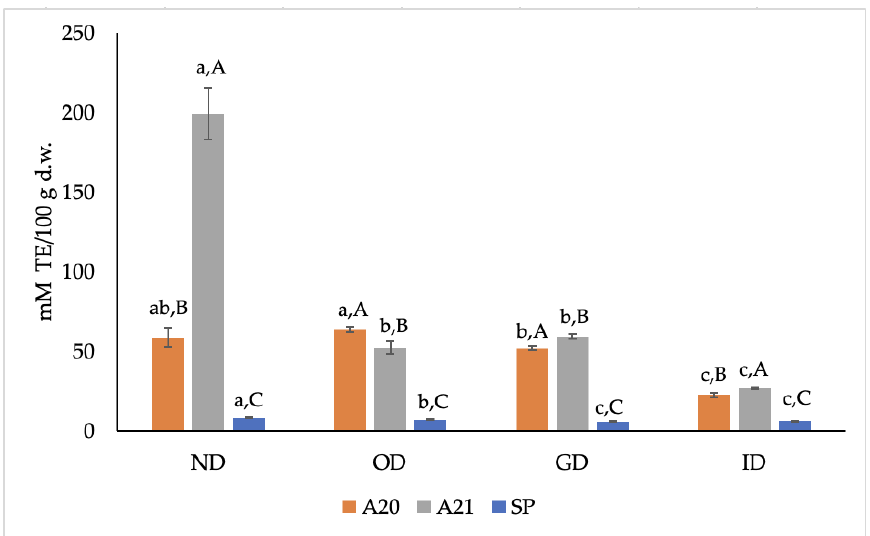
Figure 3. Effect of in vitro digestion on 2,2 ′ -azobis(2-amidinopropane) dihydrochloride (AAPH ) radical (expressed as mM TE/100 g d.w.) of the three phenolic extracts. ND: non-digested; OD: oral digestion; GD: gastric digestion; ID: intestinal digestion; SP, spray-dried. Values are means of triplicates ± standard deviation (SD); a – c, statistically different means during digestion ( p ≤ 0.05); A – C, statistically different means among samples ( p ≤ 0.05).